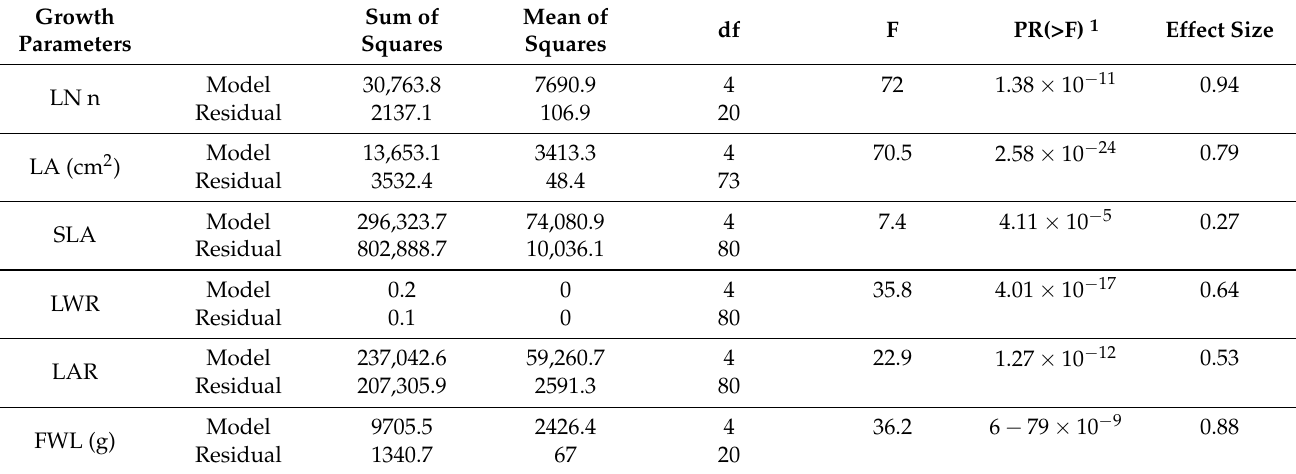
Table 1. Analysis of variance for growth